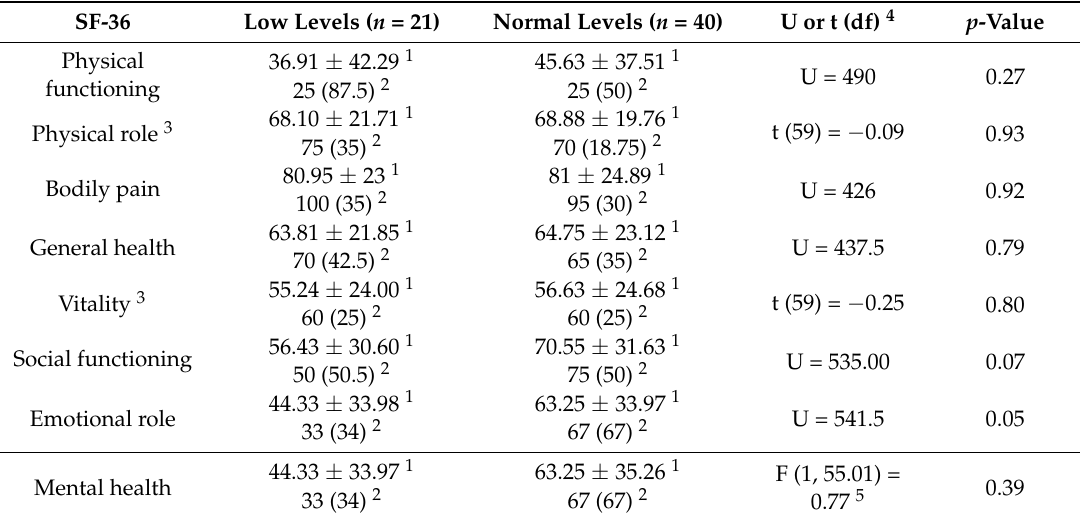
Table 10. Effects of hematocrit levels on SF-36